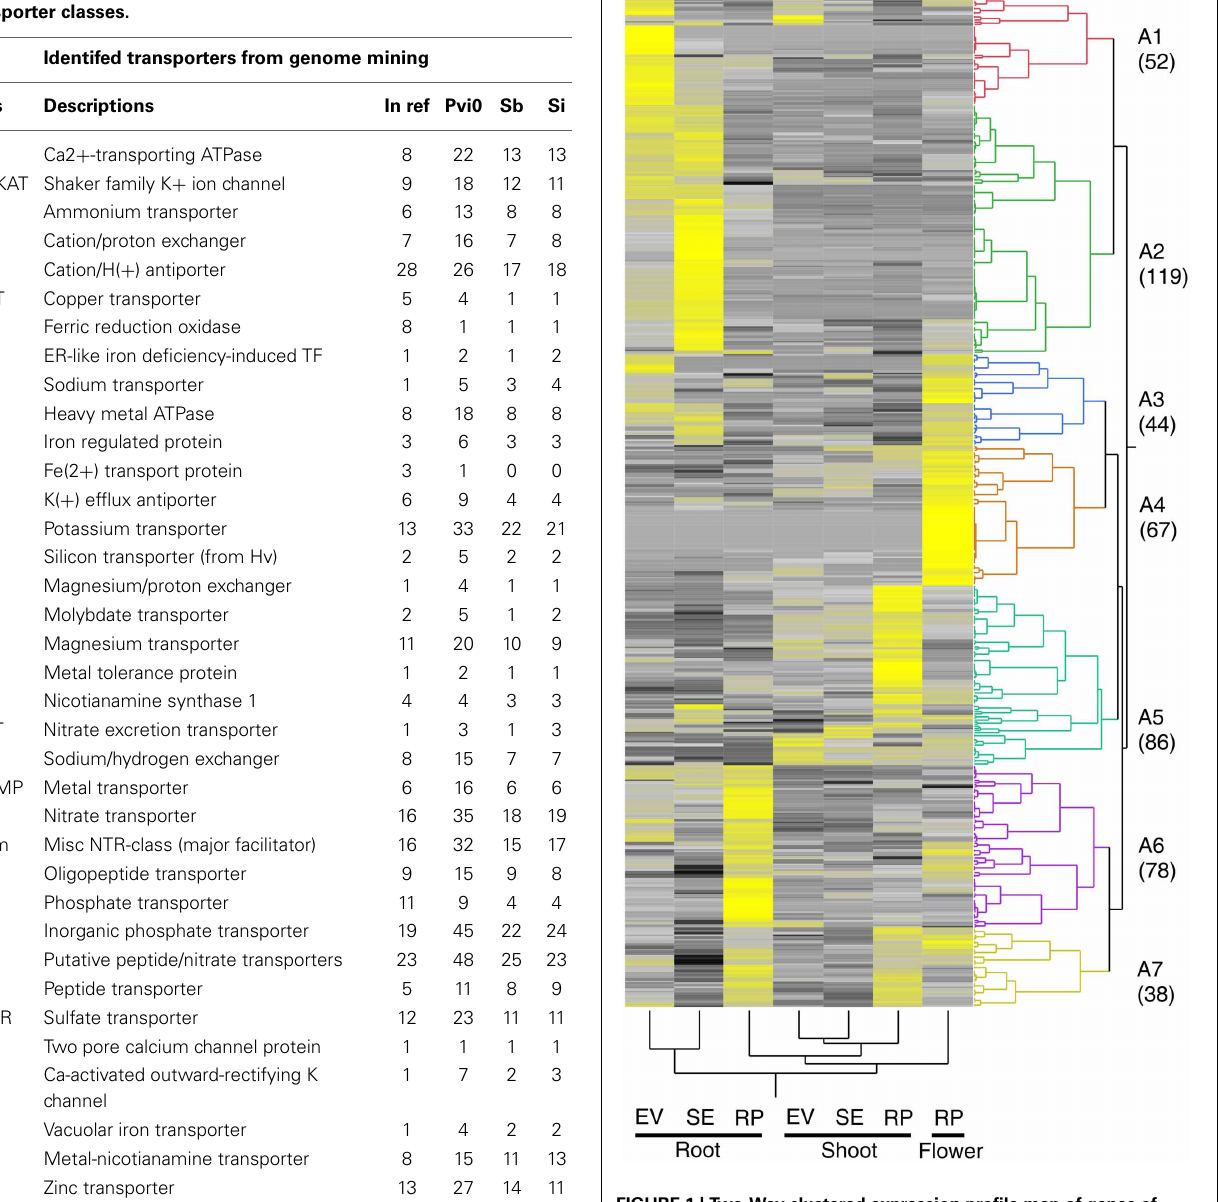
FIGURE 1 | Two-Way clustered expression profile map of genes of switchgrass nutrient transporters present in different tissues of cv Alamo plants grown in a greenhouse. Stages of plant development are early vegetative (EV), stem elongation (SE), and reproductive (RP) are as described in these datasets. Yellow indicates high abundance, gray is intermediate and black is low or negligible abundance. The clusters are labeled as A1 through A7. The numbers in parentheses under each cluster indicate the total number of transporter identified within each cluster. The appropriate SRA identification numbers for these individual NGS files are SRX057826, SRX057827, SRX057828, SRX057829, SRX057830, SRX057831, and